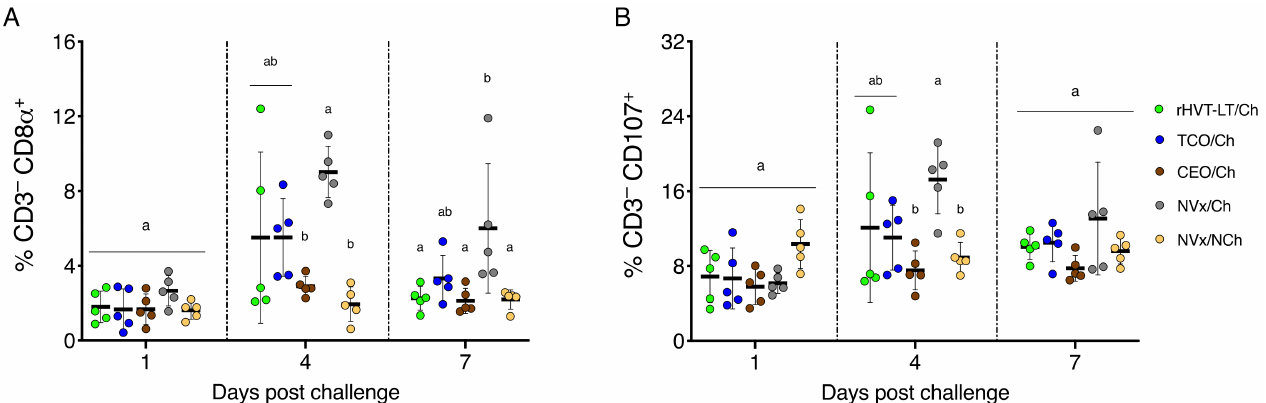
Figure 4. NK and activated NK cells in the larynx–trachea at 1, 4 and 7 dpch: ( A ) NK cells (CD3 − CD8 α + ); ( B ) activated NK cells (CD3 − CD107 + ). Small horizontal lines indicate the mean ( ± SD). Each dot represents an individual chicken (n = 5 for each group). Different letters indicate significant differences ( p <